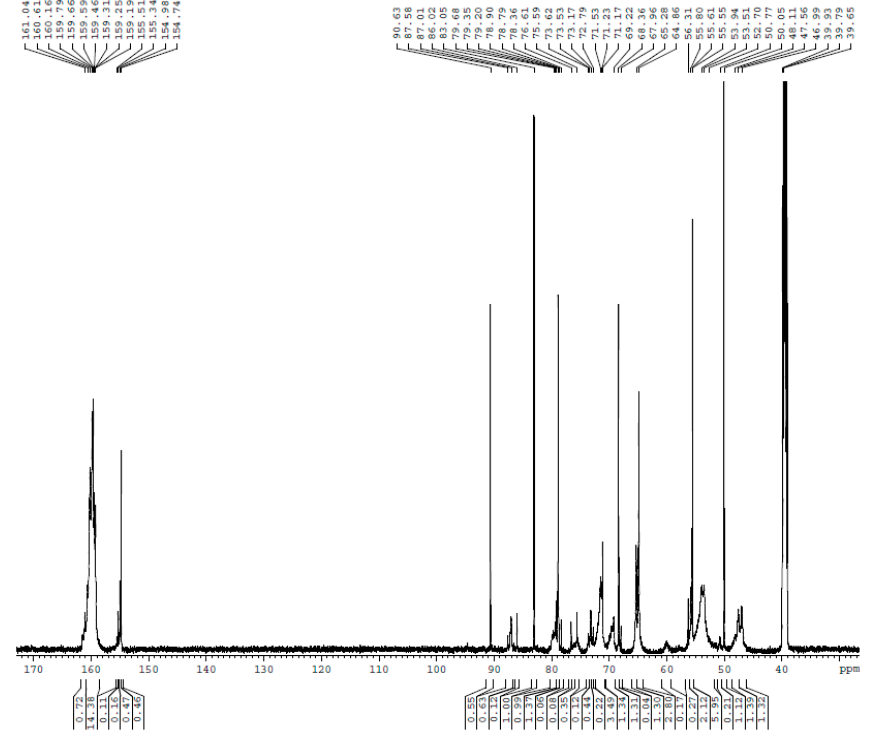
Figure 4. The 13 C NMR spectrum of sample UF-4.